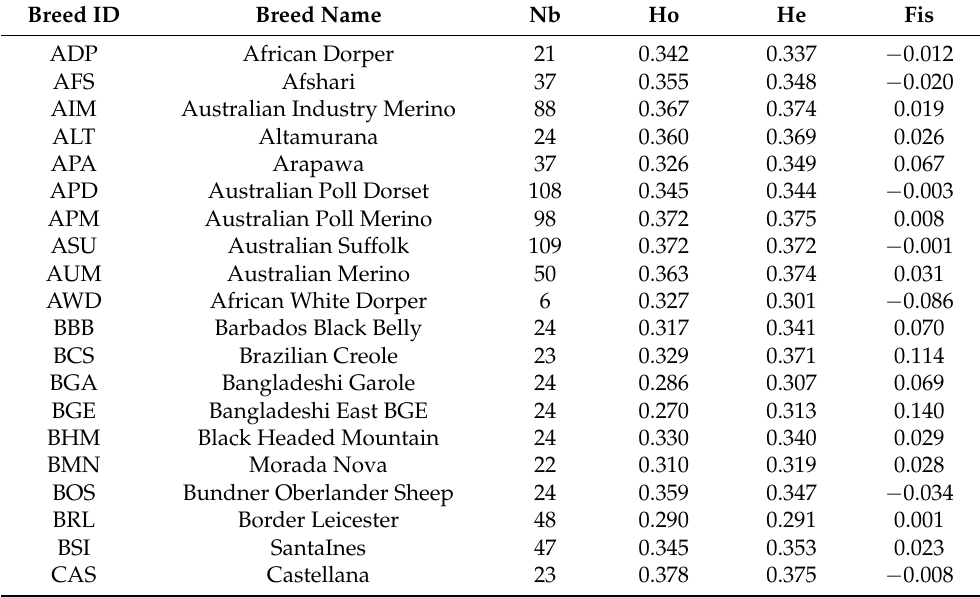
Table 4. Within-breed genetic diversity indices in 77 breeds estimated from different SNP datasets.